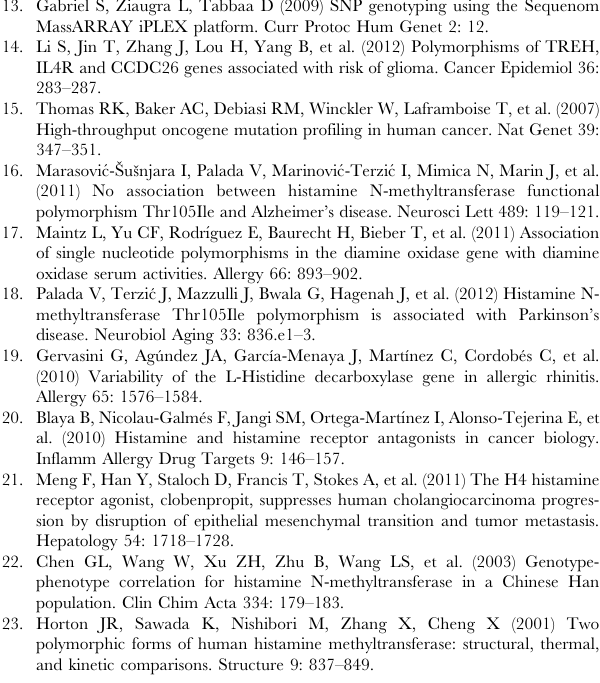
Table S2 Correlations of clinicopathological parameters and HNMT and HRH3 polymorphisms in patients with breast